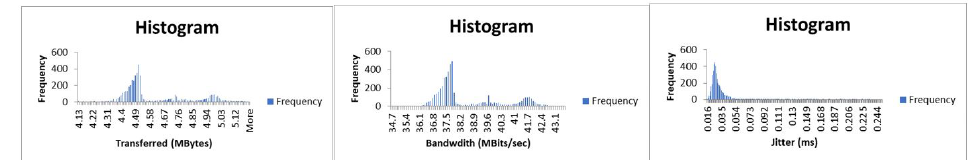
Figure 11. Node 1 with mid data rate utilized bandwidth and jitters.